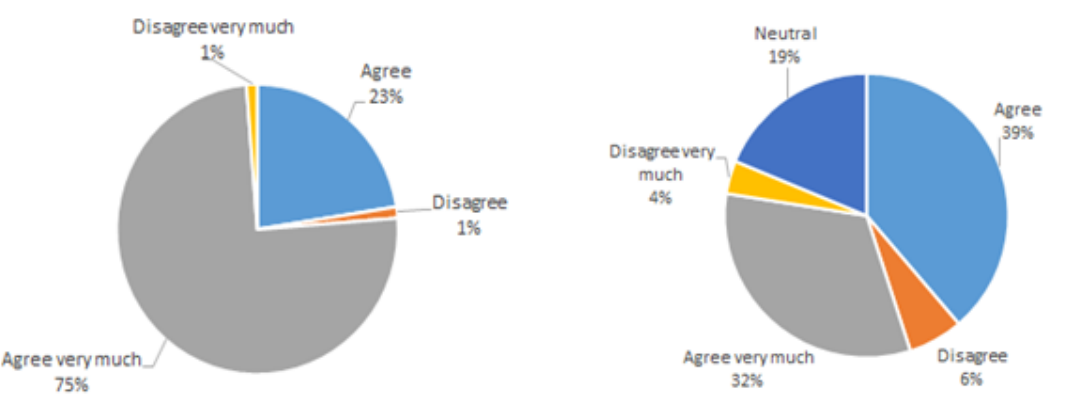
Figure 3. I attended the lectures regularly and participated actively in the work group sessions